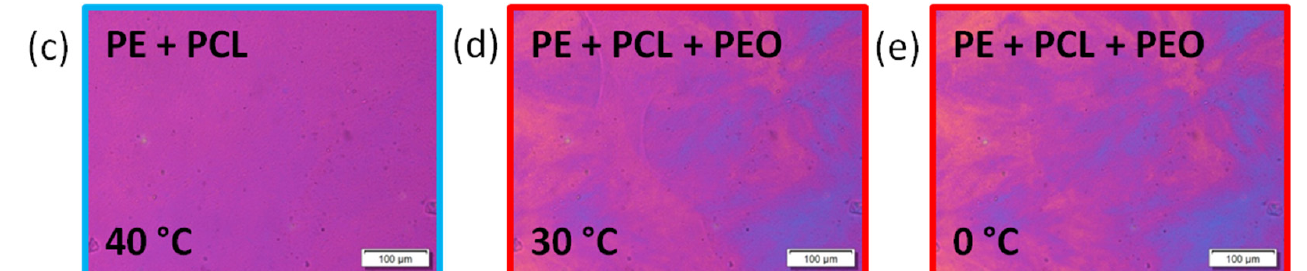
7.1 -b- PEO 4615.1 -b- PCL 3210.4 (T1) cooling 22